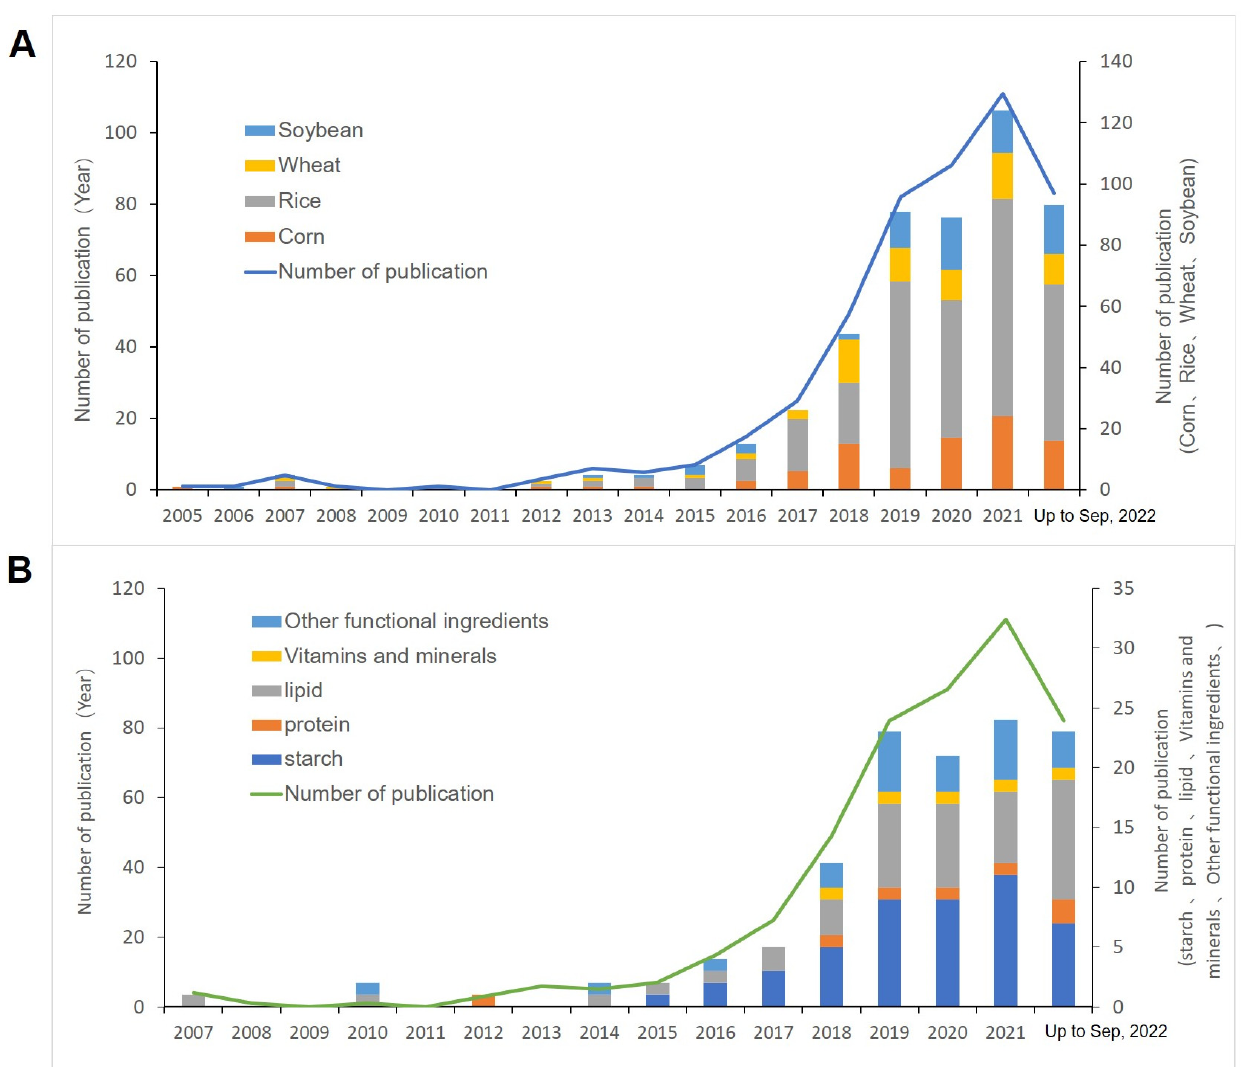
Figure 1. Number of publications and information on gene editing to improve crop quality and function. ( A ) Number of publications in the field of gene editing for improving crops based on corn, rice, wheat, and soybean from 2005 to 2022; ( B ) number of publications in the field of gene editing for improving crops using maize, rice, wheat, and soybean from 2005 to 2022.